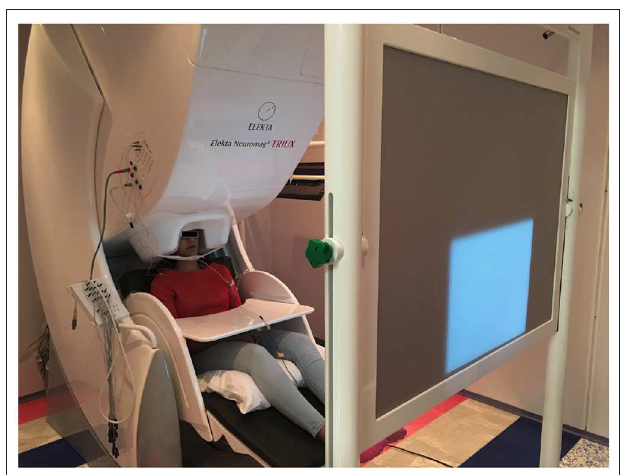
FIGURE 1 | A MEG unit. The picture represents the Neuromag Eleckta Ltd. MEG machine situated within a magnetically shielded room at the Cook Children’s Hospital, Texas. A subject is seated comfortably in the unit. The projected display is for showing the stimuli (text) in a pseudo-randomized order.